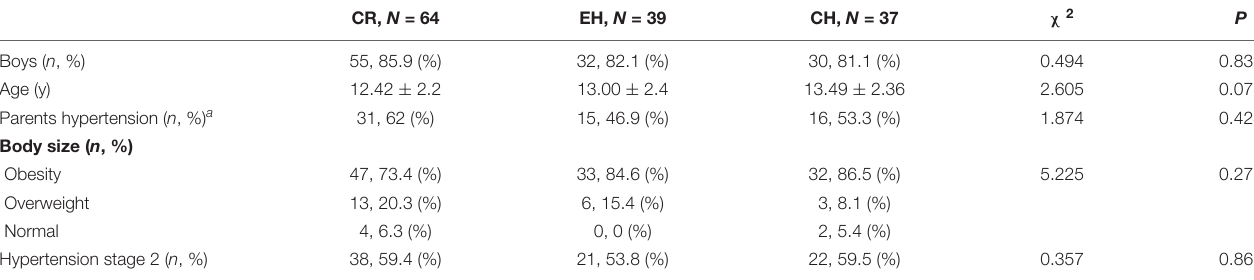
TABLE 2 | Characteristics of groups among LVH.